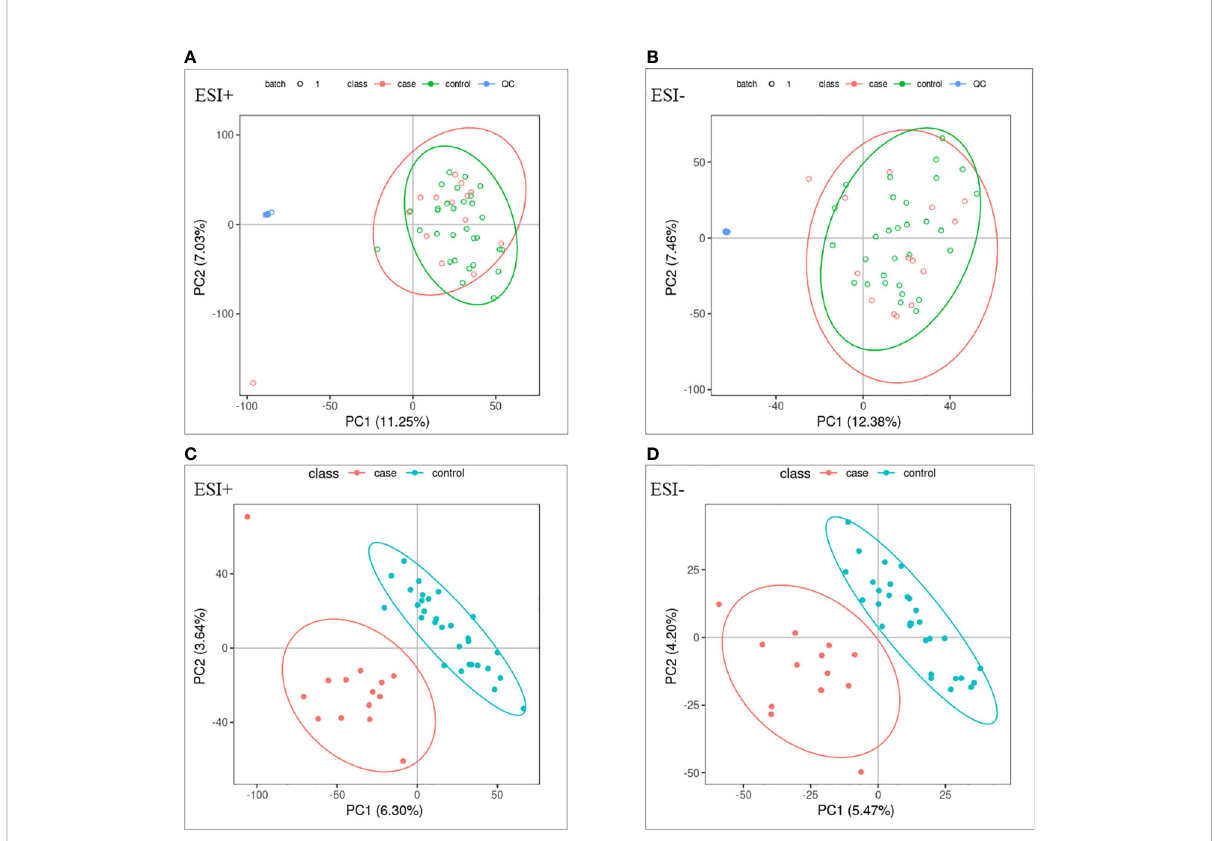
FIGURE 1 Multivariate statistical analysis. (A, B) principal component analysis scores scatter plots of the two groups. (C, D) partial least squares- discriminant analysis score scatter plots of the two groups. QC (blue circles), control group (n=30, green circles), ATB-DILI group (n=14, red